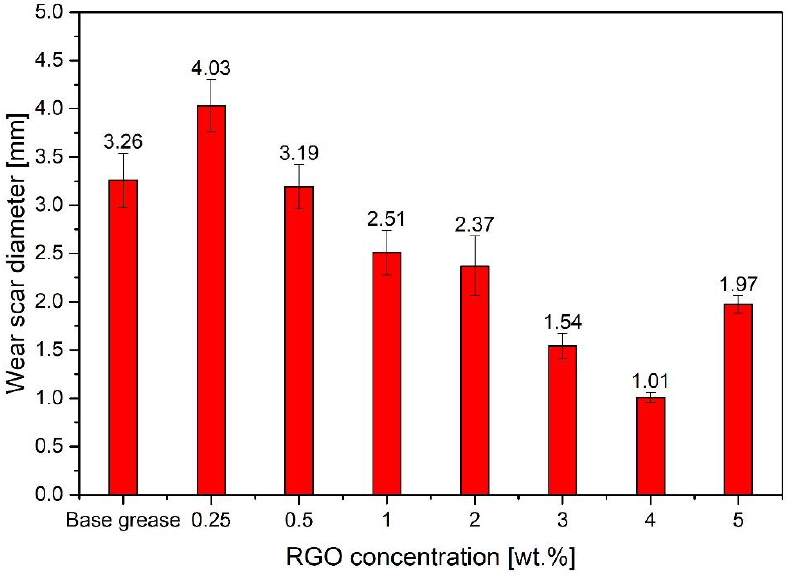
Figure 9. Influence of RGO additive concentration on the tribological properties of a lubricant. In the case of lubricant samples containing the additive in the form of RGO, the trend observed was similar to the compositions with the addition of GO. In this case, an increase in the wear of the test elements by 24% (4.03 ± 0.27 mm) was also observed compared to the base lubricant (3.26 ± 0.28 mm) for the lowest additive content of 0.25 wt.%. Increasing the concentration of graphene to 0.50 wt.% results in a wear scar with an average diameter close to the scar obtained when lubricating the node with base grease without additive. Only higher concentrations of the nanoadditive result in a significant reduction in consumption. The lowest wear was observed at 4.00 wt.%. RGO concentration (scar reduction by approx. 70%). Increase in RGO concentration in the lubricant from 1.00 to 4.00 wt.% reduces the average diameter of the wear scar from 2.51 ± 0.23 mm (23%) to 1.01 ± 0.05 mm (69%), respectively, compared to the grease without additive. Further increase of the additive content to 5.00 wt.% may increase the wear of the balls (1.97 ± 0.09 mm). It can be concluded that the RGO concentration of 4.00 wt.% in the grease is the limit concentration, exceeding which the antiwear properties of the grease may deteriorate. Even though 5.00 wt.% RGO concentration increases the consumption in relation to the concentration of 4.00 wt.%, in relation to the grease without the addition of graphene, the average diameter of wear scar was reduced by 40%. Deterioration of lubricating properties for the highest